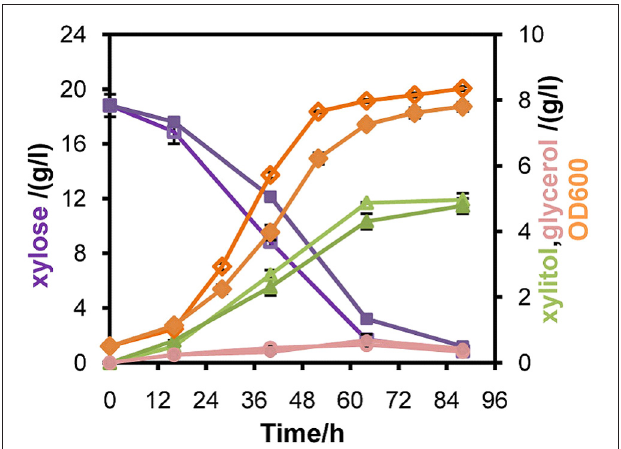
FIGURE 4 | Comparison of the performances of recombinant strain L2612PR-D (Open symbols) and its control strain L2612PR-C (Closed symbols) in xylose under aerobic conditions. L2612PR-D was integrated with one additional copy of mXYL2 in the genome. The aerobic growth was carried out in 50ml YPX medium with 20 g/l xylose. The initial OD 600 of the culture was 0.5. Symbols: diamonds, OD 600 ; squares, xylose consumption; triangles, xylitol concentration; circles, glycerol concentration. The results shown were the average value of two independent experiments.